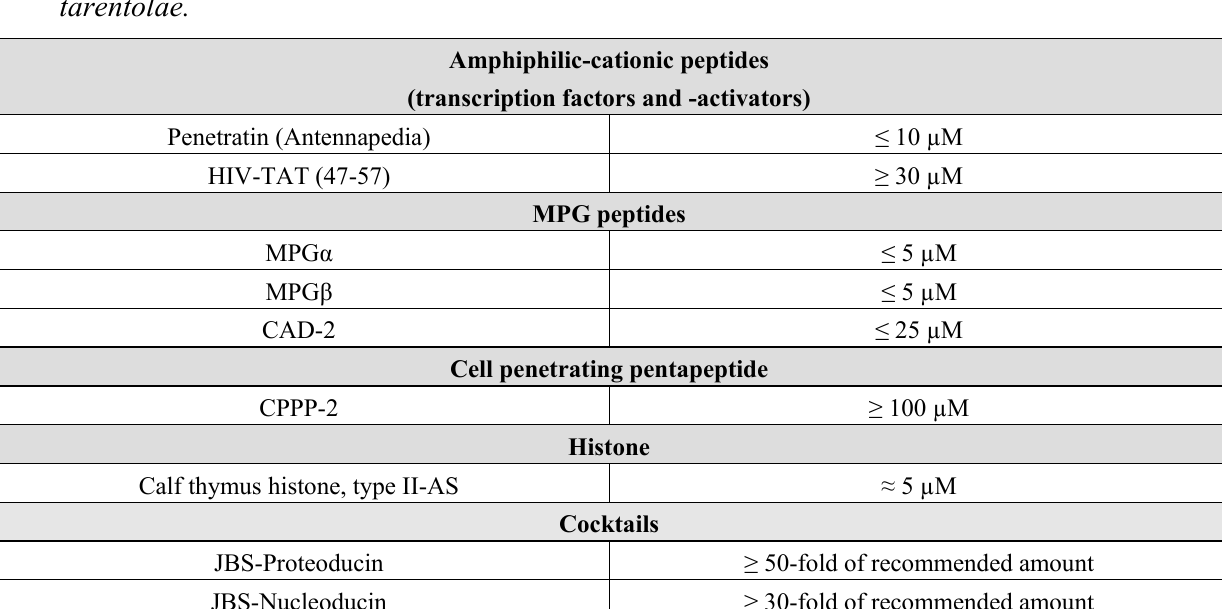
Table 5. Cytotoxicity of cell penetrating peptides and CPP cocktails in Leishmania